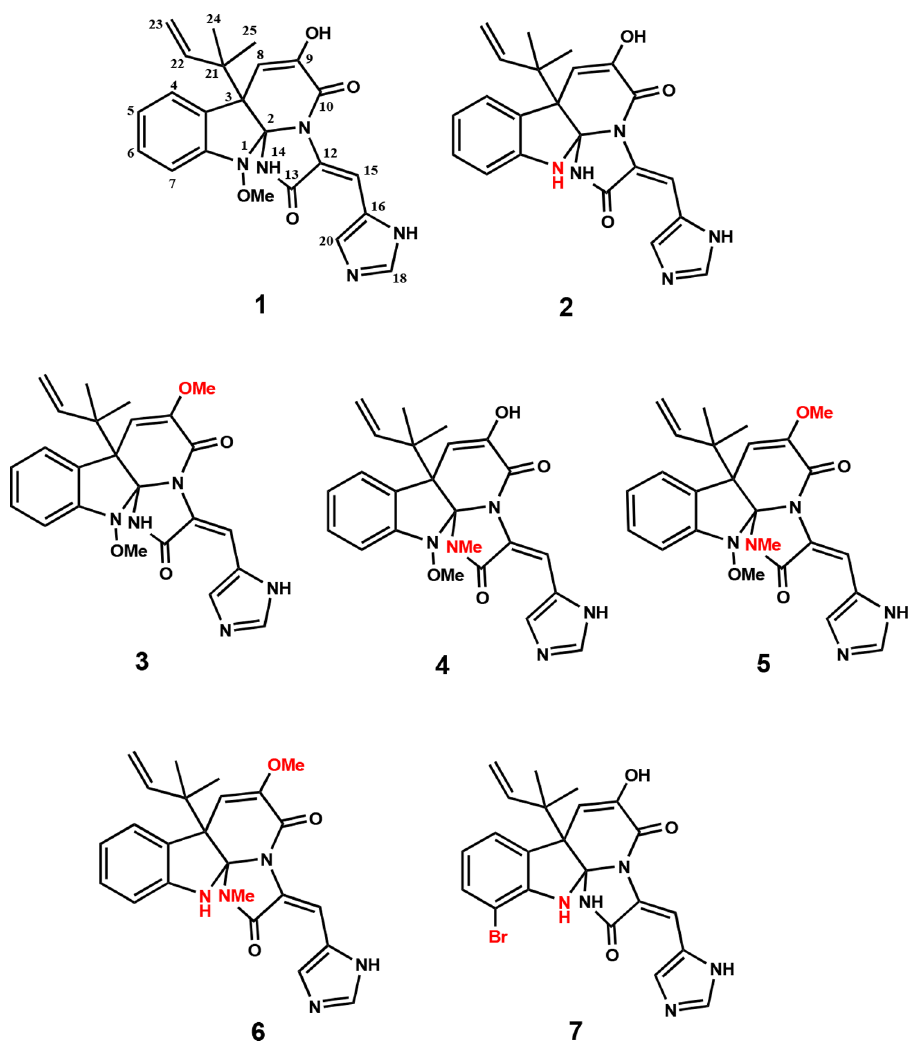
Figure 1. Meleagrin (1) and its chemically prepared derivatives.